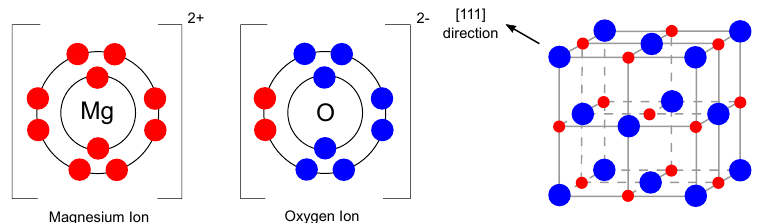
Figure 2. Electronic configuration of Mg 2 + and O 2 − ions and crystal structure of MgO (redrawn and adapted from